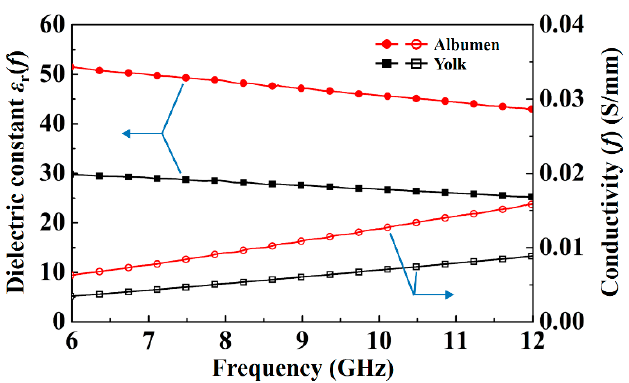
Figure 8. Measured frequency-dependent dielectric constant ε r and conductivity of yolk and albumen at X-band. Table 1. Detailed dielectric constants and conductivity of albumen and yolk.